Question: Provide a one-line summary of what is displayed.
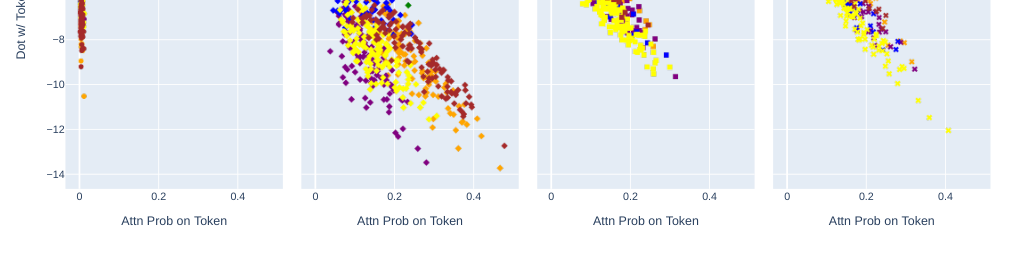
Answer: Analyzing one of the inhibition head’s (12.3) activity on the Colored Objects task shows that it is attending strongly to test color words and the in-context label (and writing in the opposite direction in embedding space, when attention is high), although they do not affect the mover heads as they do in IOI. Scatter plots for the other two inhibition heads are shown in Appendix D.3. Colors indicate the color of the word being attended to. See Appendix B for explanations of the axes.